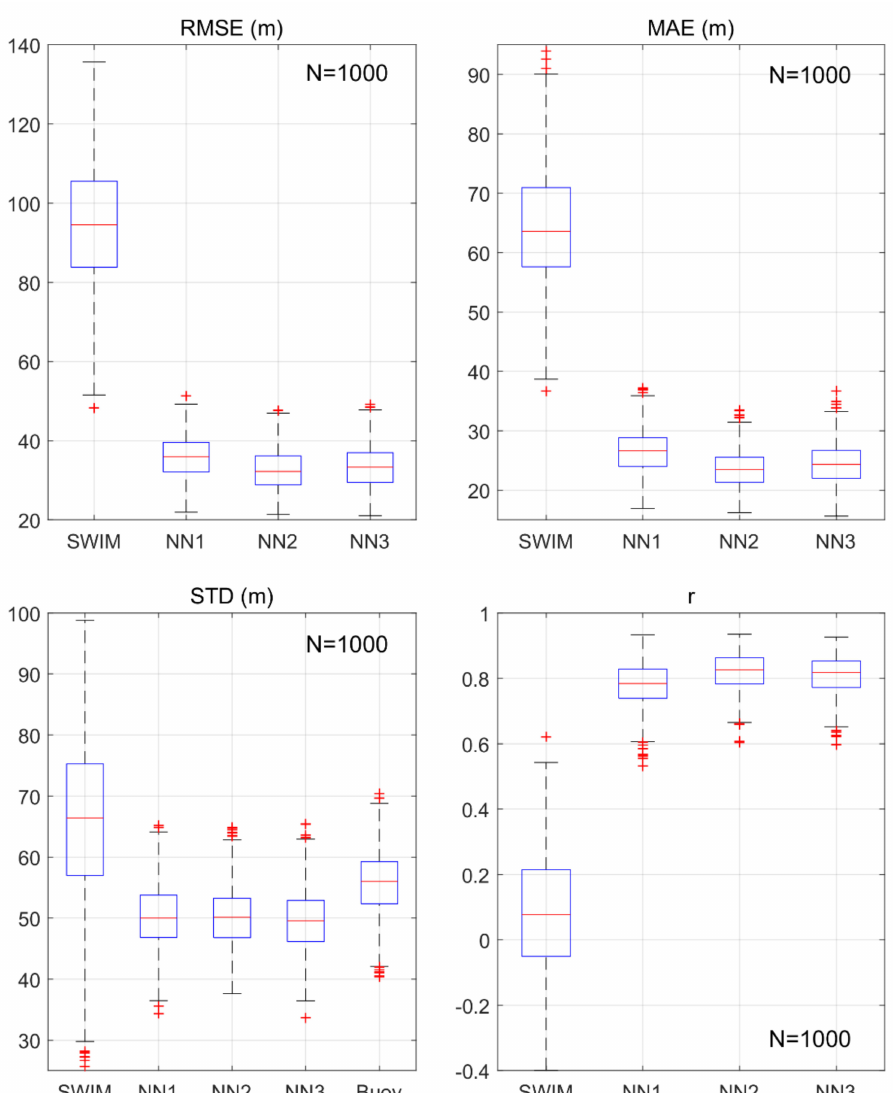
Figure 9. Same as Figure 7 but for external-source calibration, ERA5 parameters are also included (i.e., Tables 1 and 2) in the NN models. Points in red “+” are drawn as outliers if they are larger than the maximum (Q3 + 1.5 × (Q3 − Q1)) or smaller than the minimum (Q1 − 1.5 × (Q3 − Q1)), where Q1 and Q3 are the 25th and 75th percentiles,